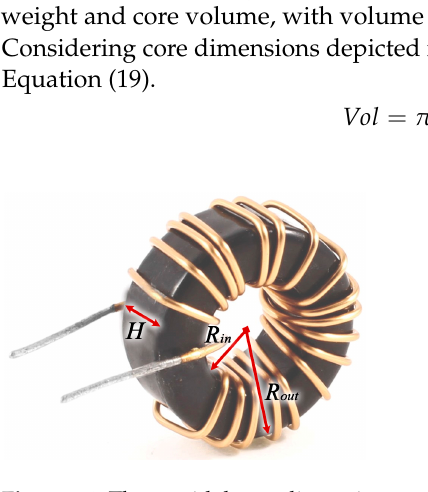
Figure 14. The toroidal core dimensions.